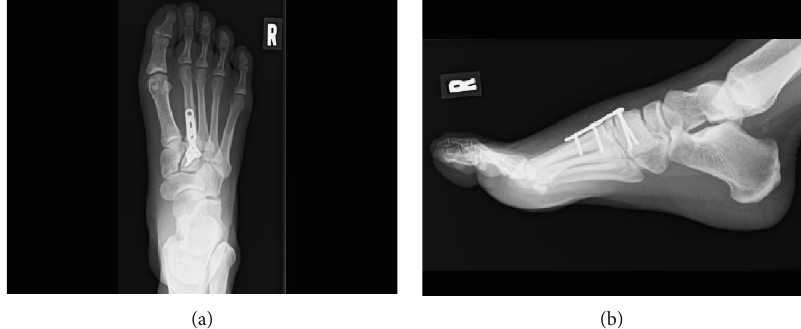
Figure 3: Postoperative (a) anteroposterior and (b) lateral foot radiographs. The nonunion site was fi xed using the bridging plate fi xation technique with a locking plate, which was placed between the distal fragment of the second metatarsal and the medial